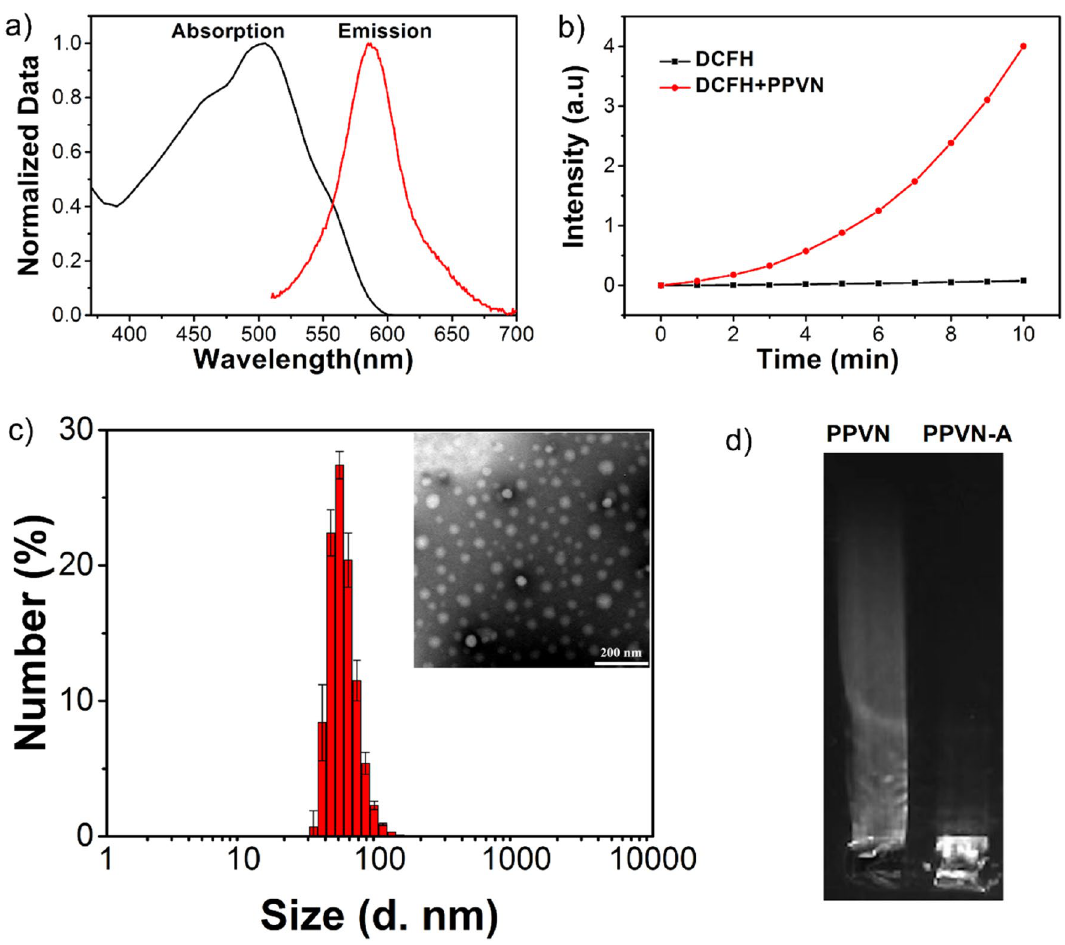
Figure 1. ( a ) Absorption and emission spectra of PPVN. ( b ) Fluorescence intensity of DCFH in the absence and presence of PPVN. ( c ) The dynamic size distribution TEM image of PPVN. ( d ) Gel electrophoresis of PPVN and